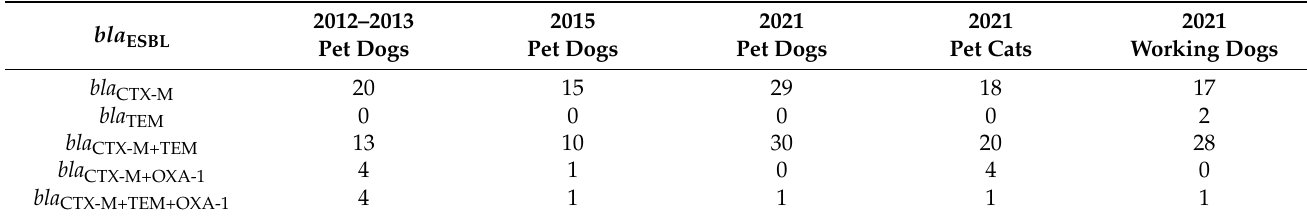
Table 1. bla ESBL types of ESBL producers from 2012 to 2021.